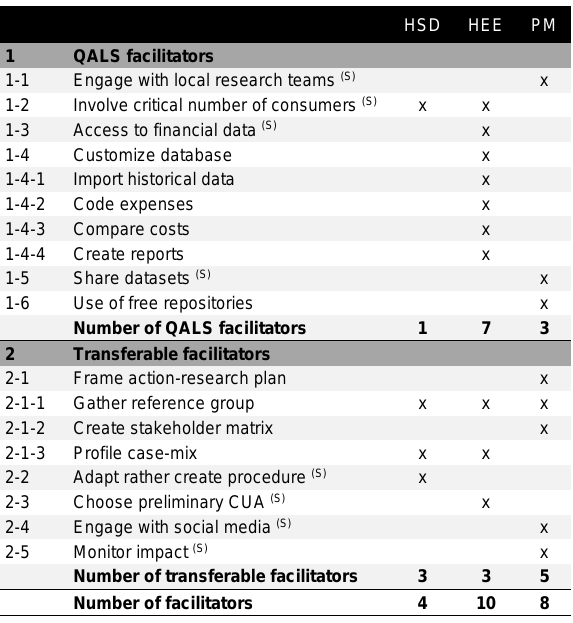
Table 5: List of specific and transferable facilitators related to health service delivery (HSD) and/or health economic evaluations (HEE) and/or project management (PM) encountered during research focusing on the provision of lower limb bone-anchored prostheses (BAP) led by the Queensland Artificial Limb Service (QALS). ((S): Detailed description to be published in a Data In